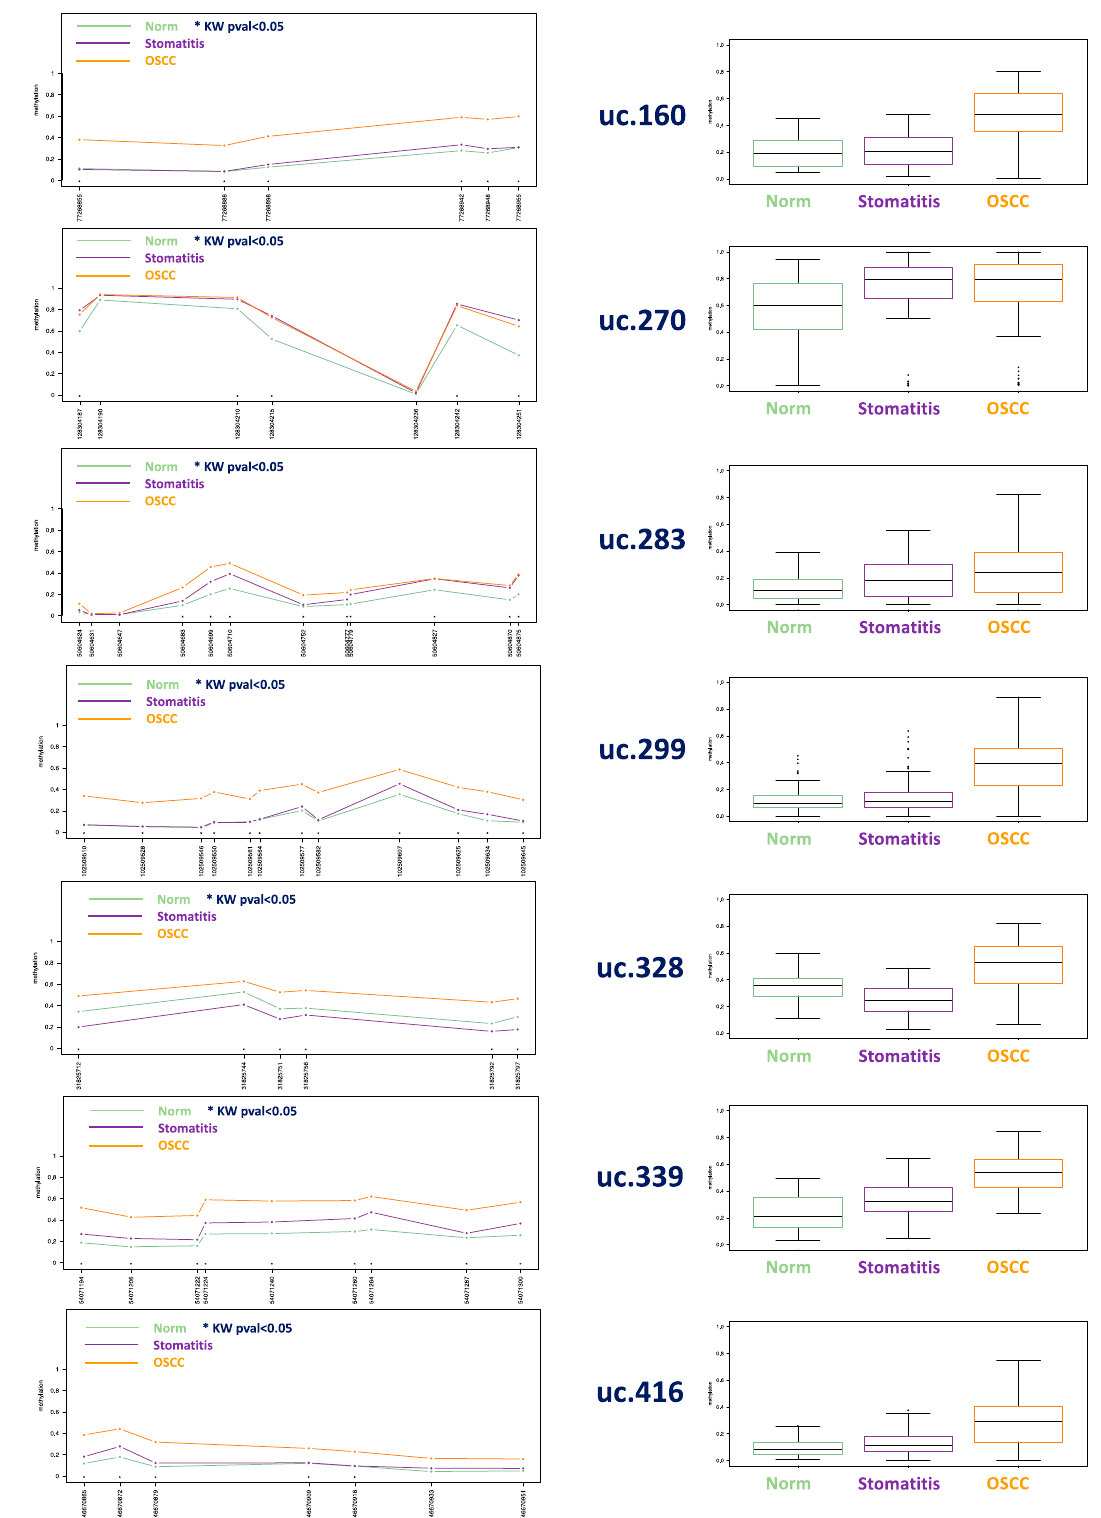
Figure 3. Methylation plot ( left ) and boxplot ( right ) comparing 17 feline SCCs with 14 feline stomatitis, and 7 normal oral epithelium in healthy cats. p -values < 0.01 was detected for all CpGs with * mapped in uc.160, uc.270, uc.328, uc.339, uc.416, and uc.283 except for CpG 50604683 ( p = 0.041), CpG 50604752 ( p = 0.017), CpG 50604777 ( p = 0.033), and CpG 50604827 ( p = 0.049) (uncorrected p -values, see Supplementary Table S3 for details).